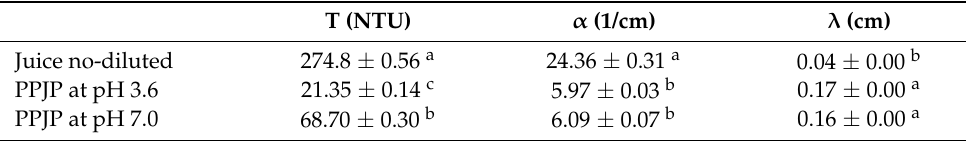
Table 1. Optical properties of red prickly pear juice. T (NTU) α (1/cm) λ (cm) Juice no-diluted 274.8 ± 0.56 a 24.36 ± 0.31 a 0.04 ± 0.00 b PPJP at pH 3.6 21.35 ± 0.14 c 5.97 ± 0.03 b 0.17 ± 0.00 a PPJP at pH 7.0 68.70 ± 0.30 b 6.09 ± 0.07 b 0.16 ± 0.00 a Mean ± standard deviation. T = Turbidity, α = absorption coefficient, λ = depth penetration, PPJP = prickly pear juice diluted (1:3). Different superscript by column represent significantly different mean ( p < 0.05), by Tukey’s